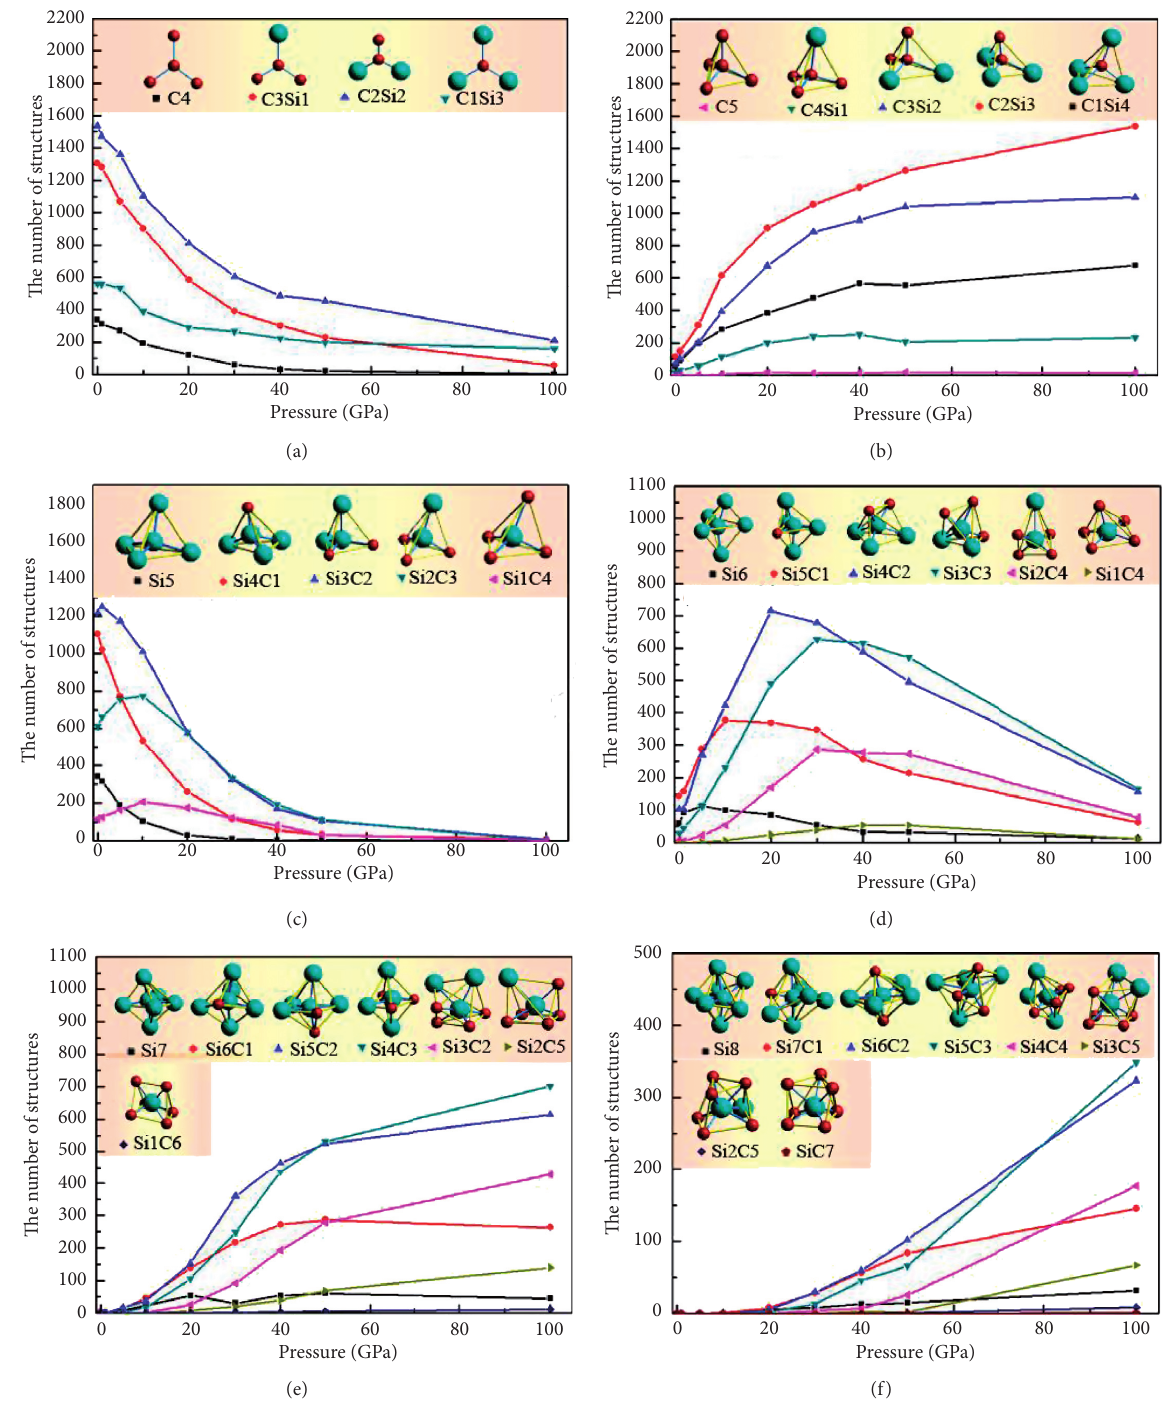
Figure 14: Pressure-dependent changes in the main structure with C and Si atoms as the central atom